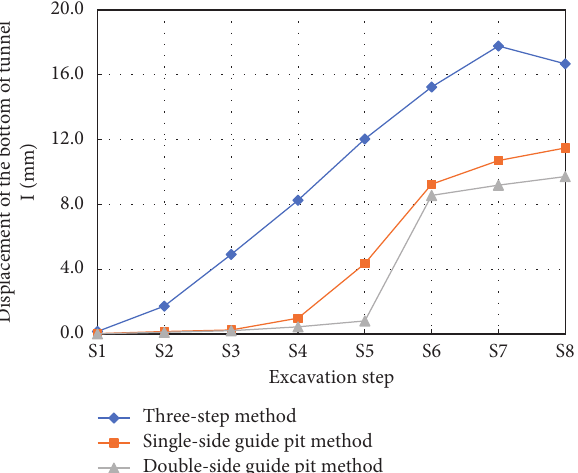
Figure 33: Displacement of the bottom of tunnel I.